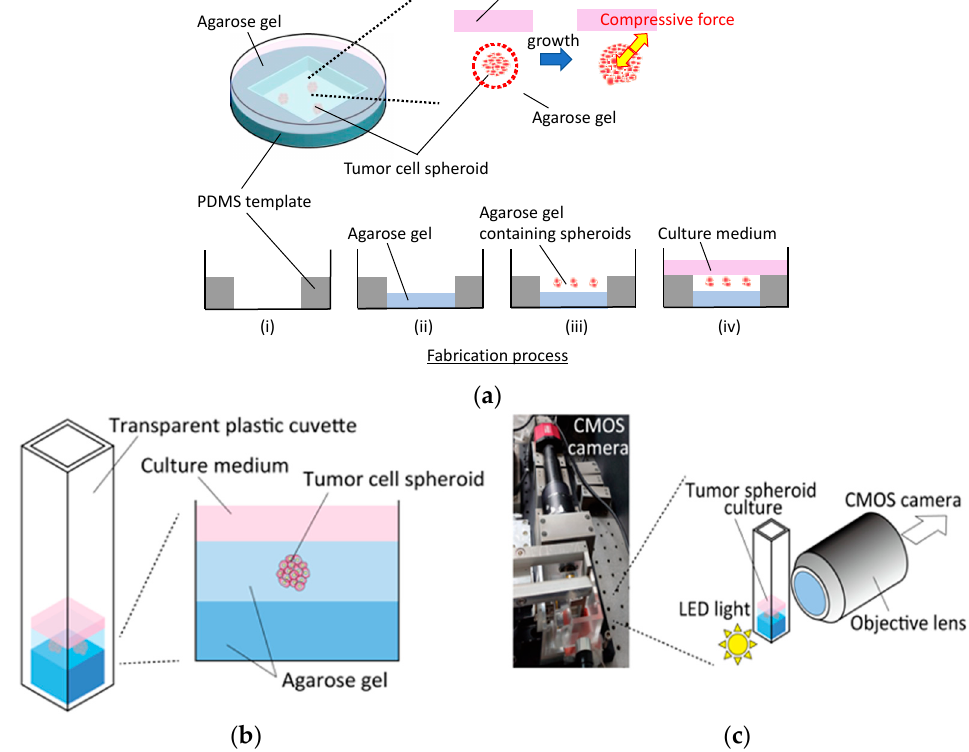
Figure 1. Fabrication and observation procedures of tumor spheroid culture confined in agarose gels. Fabrication process of ( a ) a petri-dish-based culture and ( b ) a transparent cuvette-based culture with ( c ) a custom microscopy system to enable observation from the side of the cuvette.